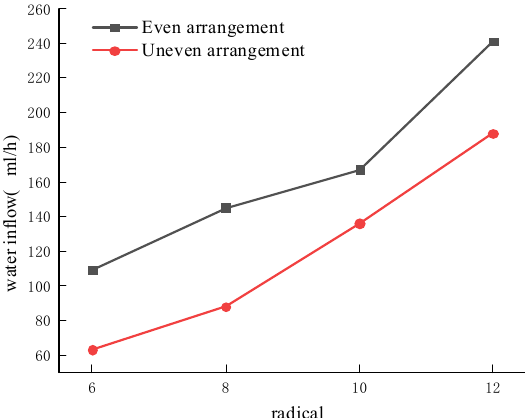
Figure 19. A seepage effect diagram of the nylon rope fiber bundle.